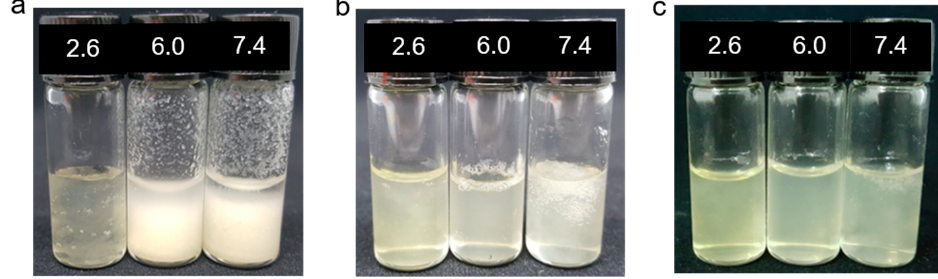
Figure 2. Solubility of ( a ) CS, ( b ) WCS30, and ( c ) WSCS90 at different pHs (2.6, 6.0, and